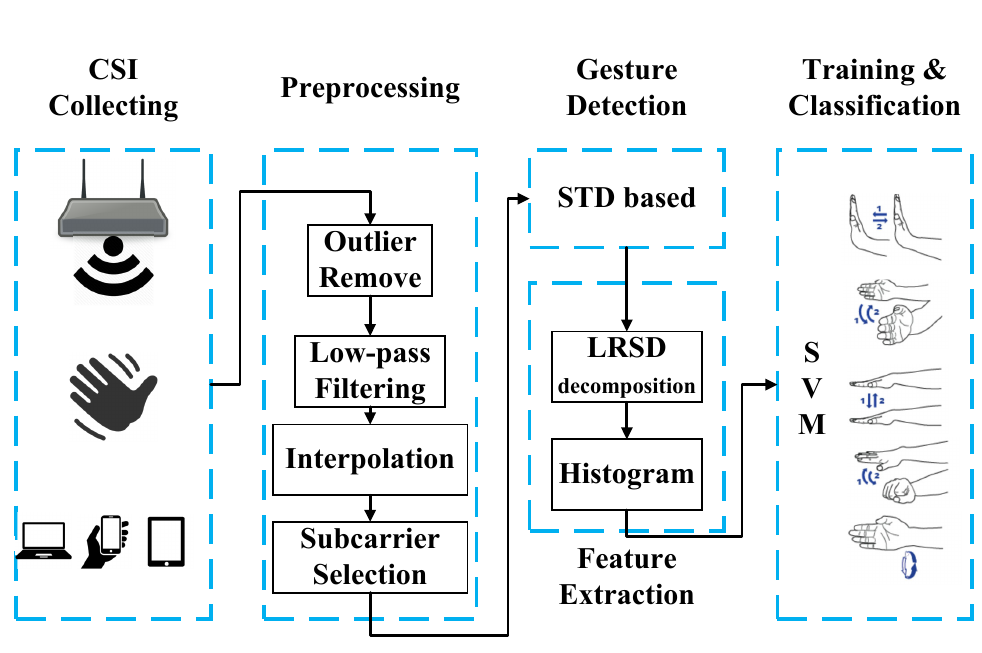
Figure 3. Outline of the WiHand